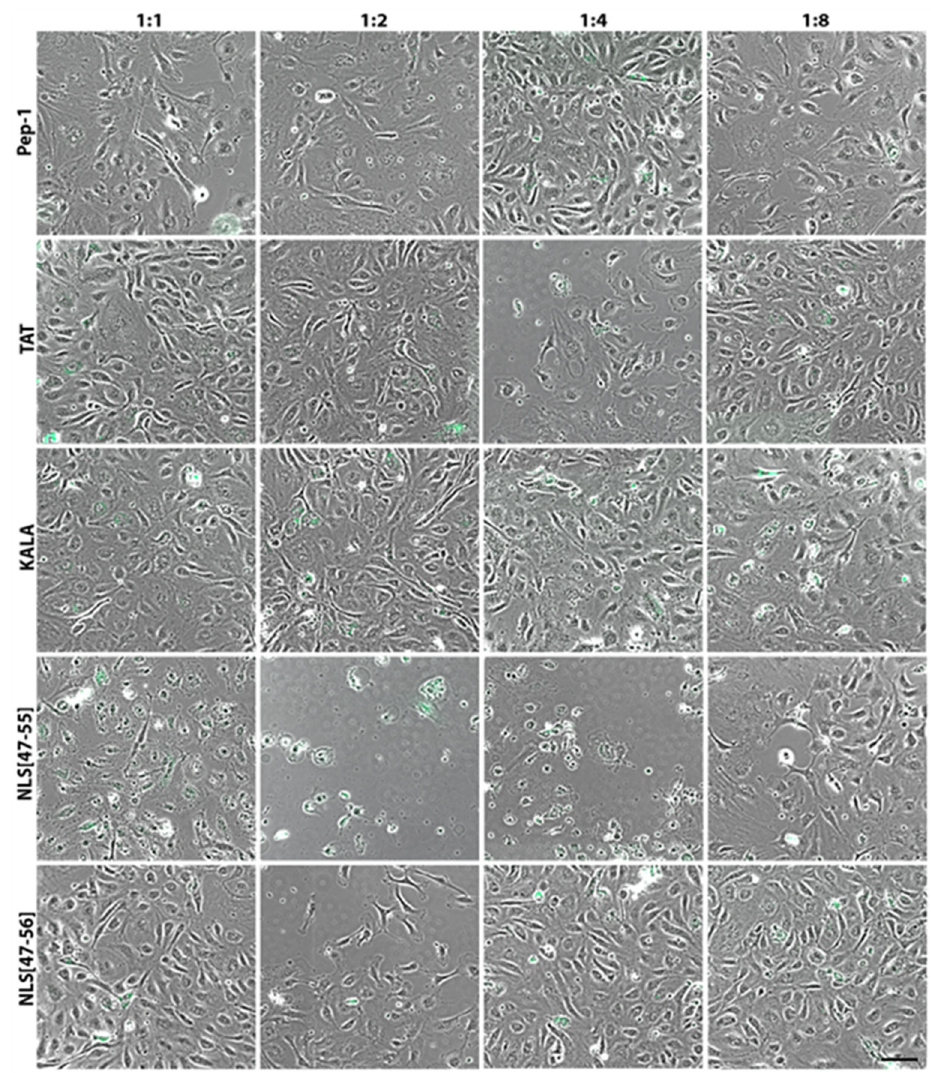
Figure 9. Effect of 24 h culture in the presence of complexes in CRs of 1:1, 1:2, 1:4 and 1:8. The complexes were formed using incubation of 2 μ g pmaxGFP with chosen CPPs at 37 °C for 15 min. CR, charge ratio. ( A ) Transfection efficiency. ( B ) Percent of cells with abnormal morphology. Data are presented as means, numbers in parentheses represent standard deviations.